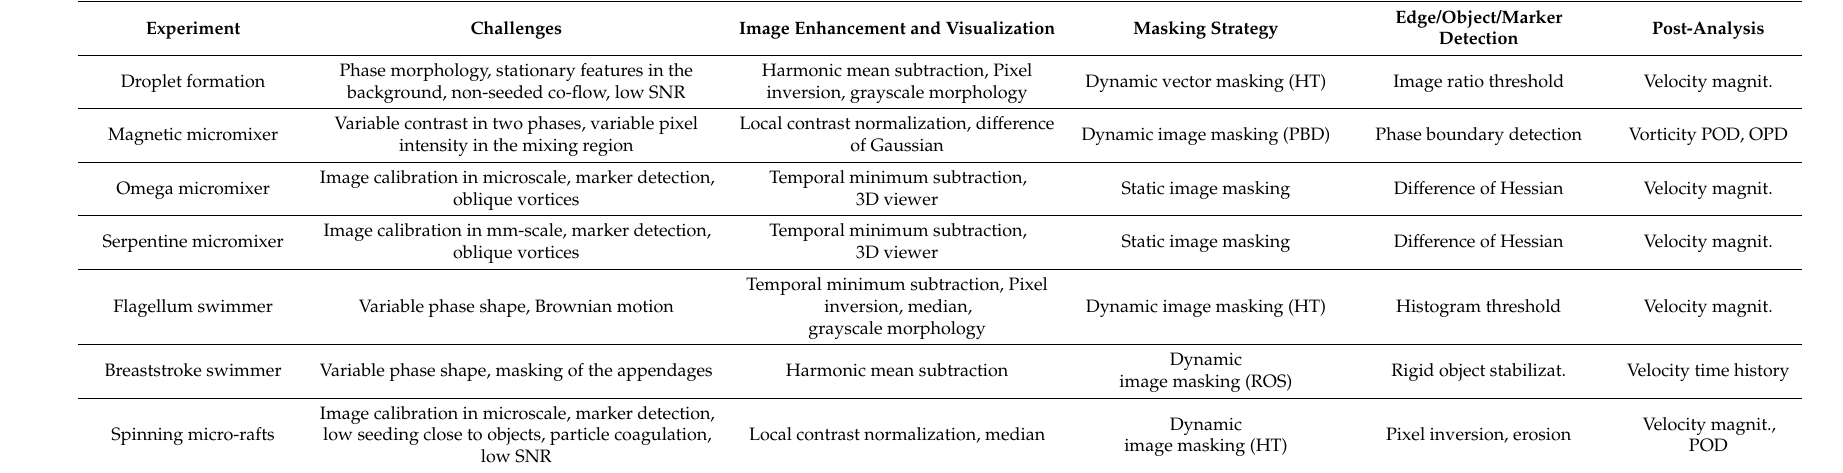
Table 2. Summary of challenges and image enhancement tools used during the